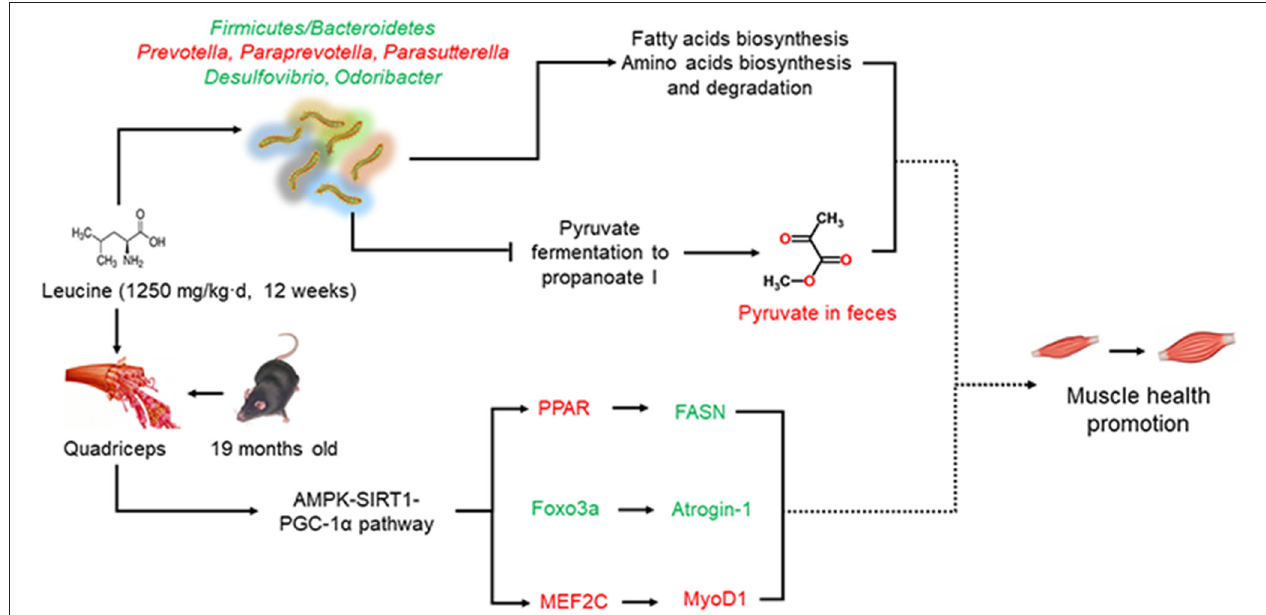
FIGURE 7 | Schematic diagram of present work. Chronic high dose of leucine supplementation could promote muscle health via regulating AMPK α /SIRT1/PGC-1 α . Besides, chronic high dose of leucine supplementation altered the composition and diversities of gut microbiota as well as increased pyruvate levels in the feces. Whether microbiota-related pyruvate level may correlate with the effects of chronic high dose of leucine supplementation on muscle health in the aging mice requires further study. Red indicates increased relative abundances or the expression levels while green denotes decreased relative abundances or expression